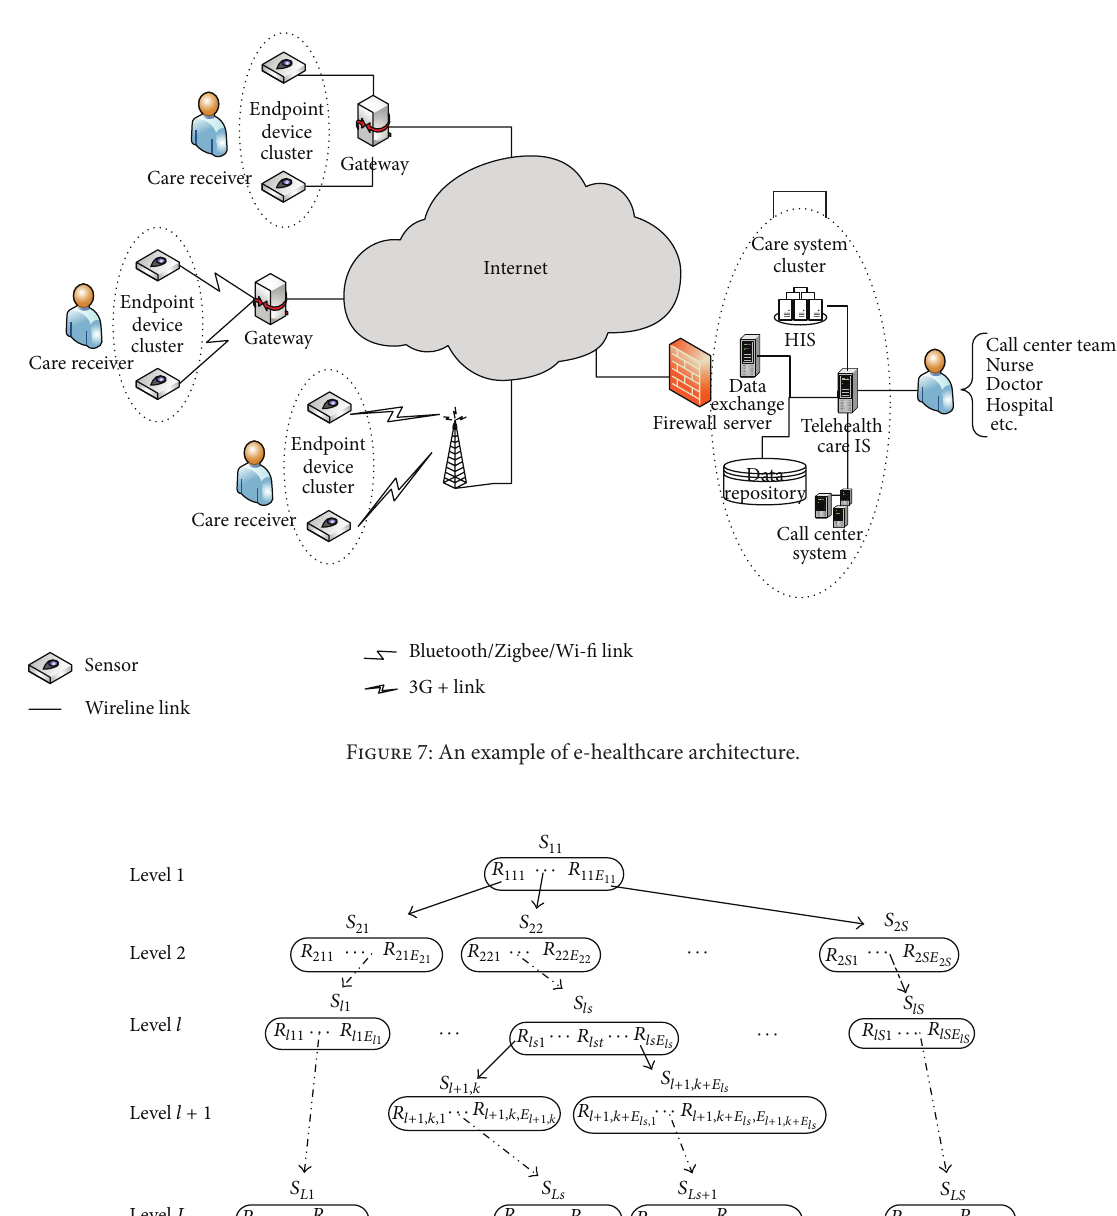
Figure 8: Hierarchy of e-healthcare service architecture.